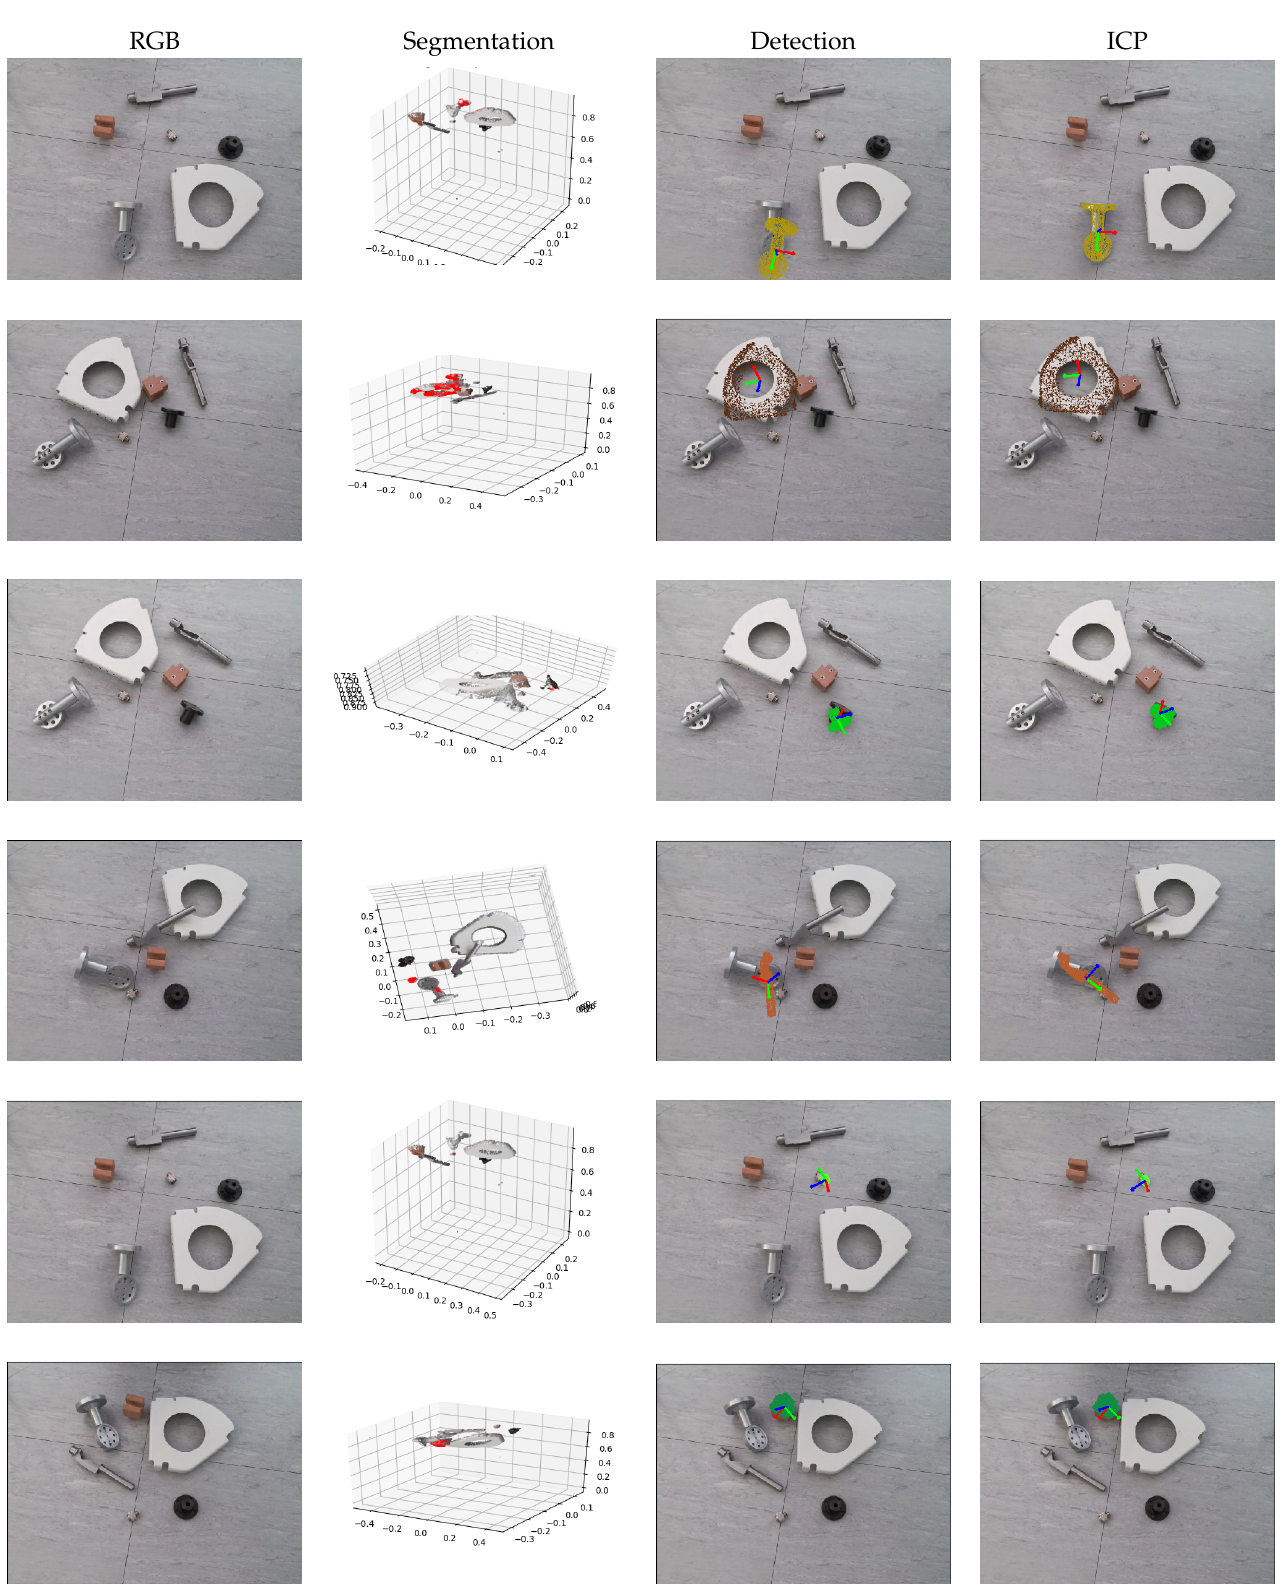
Figure 11. Detection results of the real objects. Each row corresponds to an object numbered from Object 1 to Object